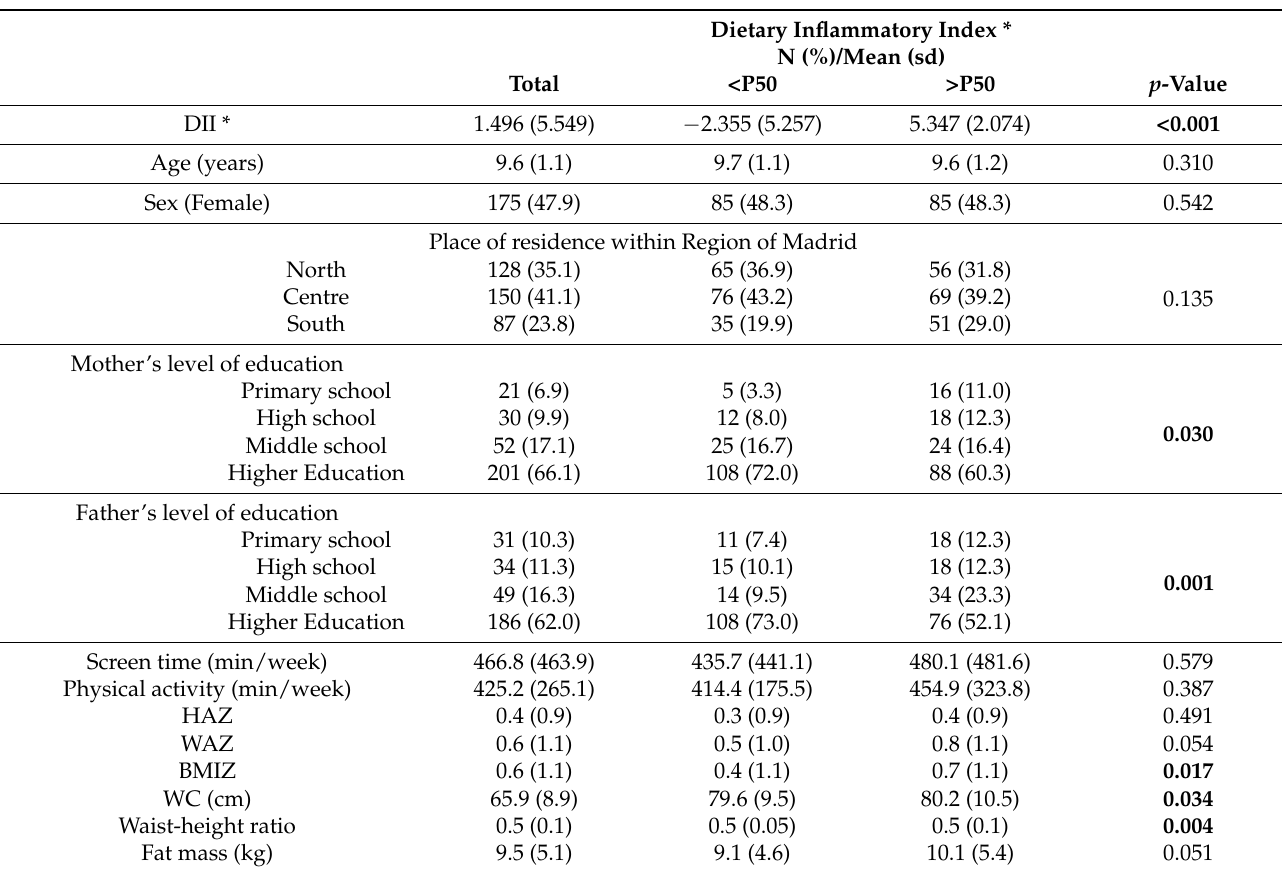
Table 4. Differences in socioeconomic, anthropometric, and hemodynamic characteristics between subjects with or a without a Dietary Inflammatory Index above the 50th